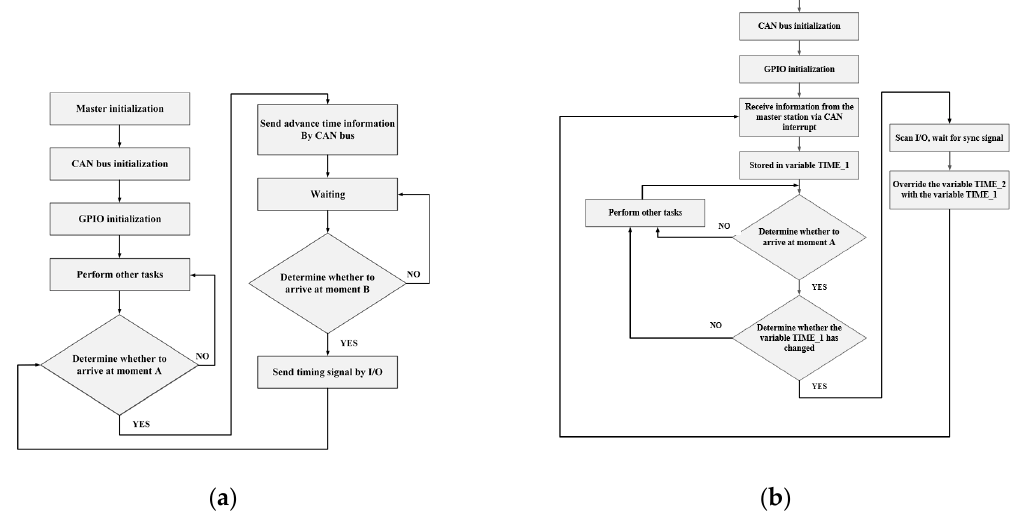
Figure 9. ( a ) Time synchronization master flow diagram; ( b ) Time synchronization slaver flow diagram.